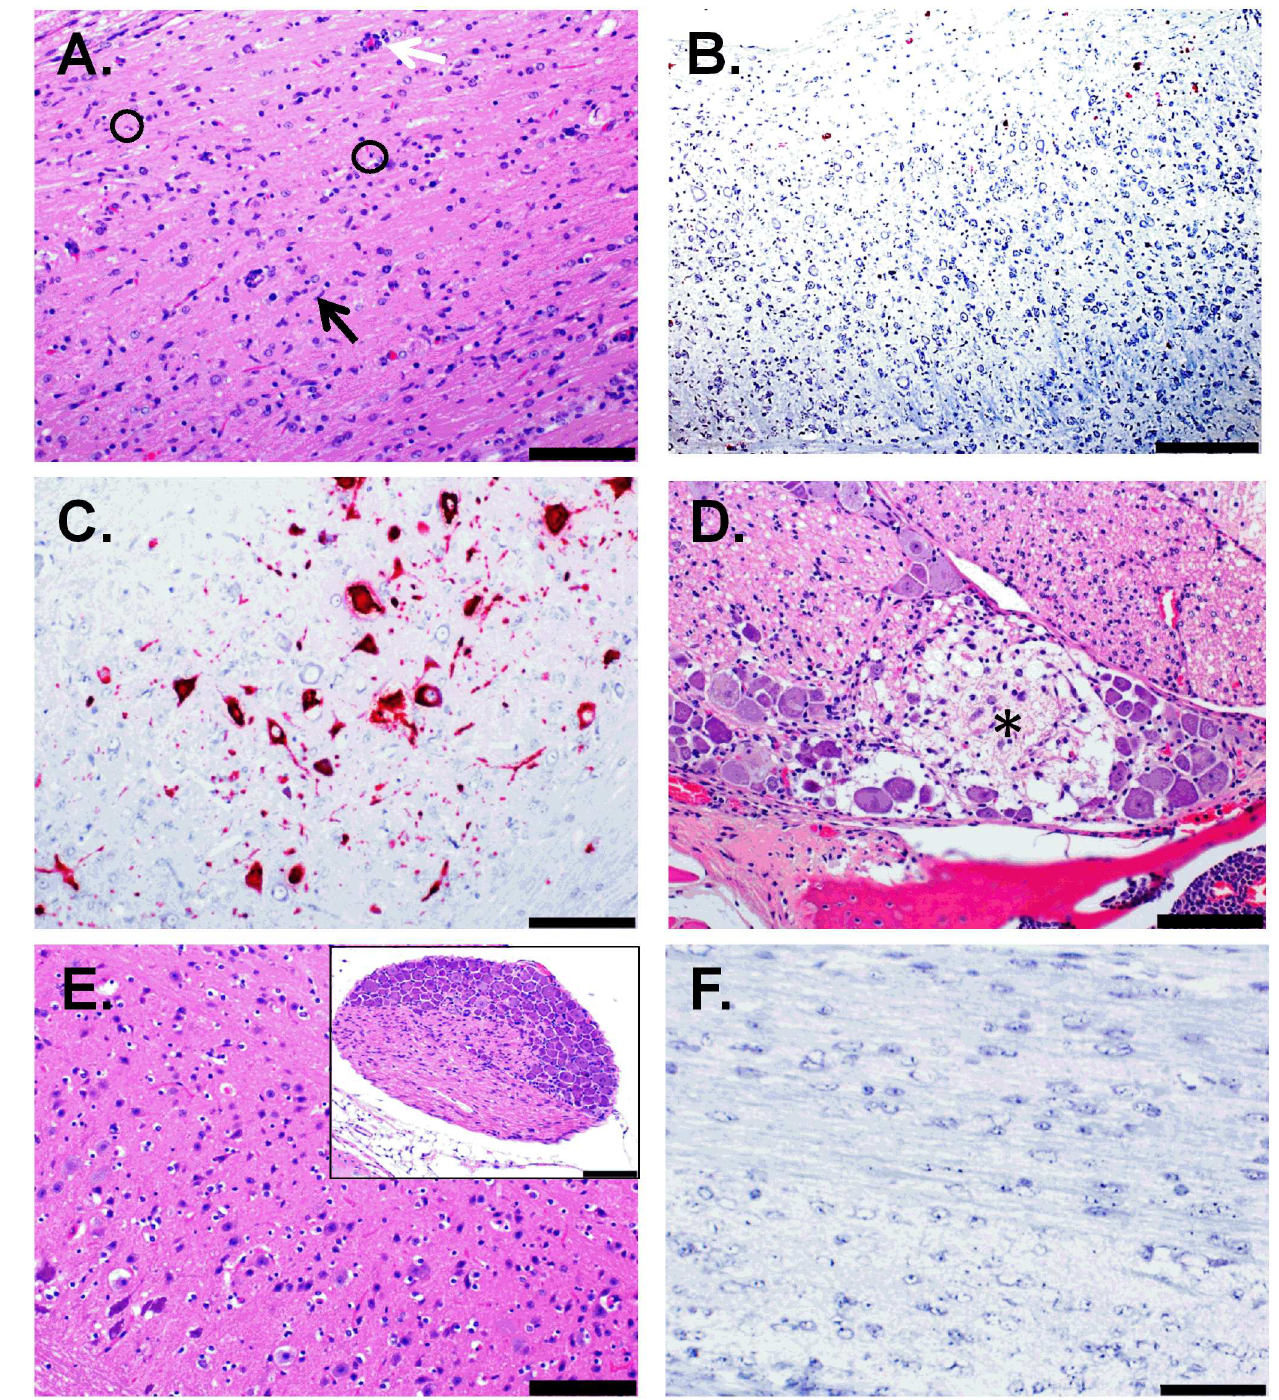
Fig 5. Histologic and ISH Findings in the spinal cord of ZIKV-Infected Wild-type Mice Treated with an IFNAR1-Blocking MAb and Uninfected Control Mice. (A-B) The spinal cord of a mouse that was exposedto ZIKV subcutaneously (SC) and euthanized on day 8 post- infection(PI). (A) Representative hematoxylin and eosin staining showed there is scattered necrotic cellulardebris (representative areas indicatedby circles), gliosis(representative cells indicatedby black arrow), and perivascular cuffing (indicated by white arrow); scale bar represents 100 μ m. (B) Representative ISH staining demonstrating that ZIKV RNA is detected throughoutthe same region; scale bar represents 200 μ m. (C) ISH staining demonstrating massive ZIKV infectionin the spinalcord of a mouse that was exposedto ZIKV intraperitoneally (IP) and was euthanized on day 7 PI; scale bar represents 100 μ m. (D) Hematoxylin and eosin stainingof spinal ganglion demonstrates a focal area of